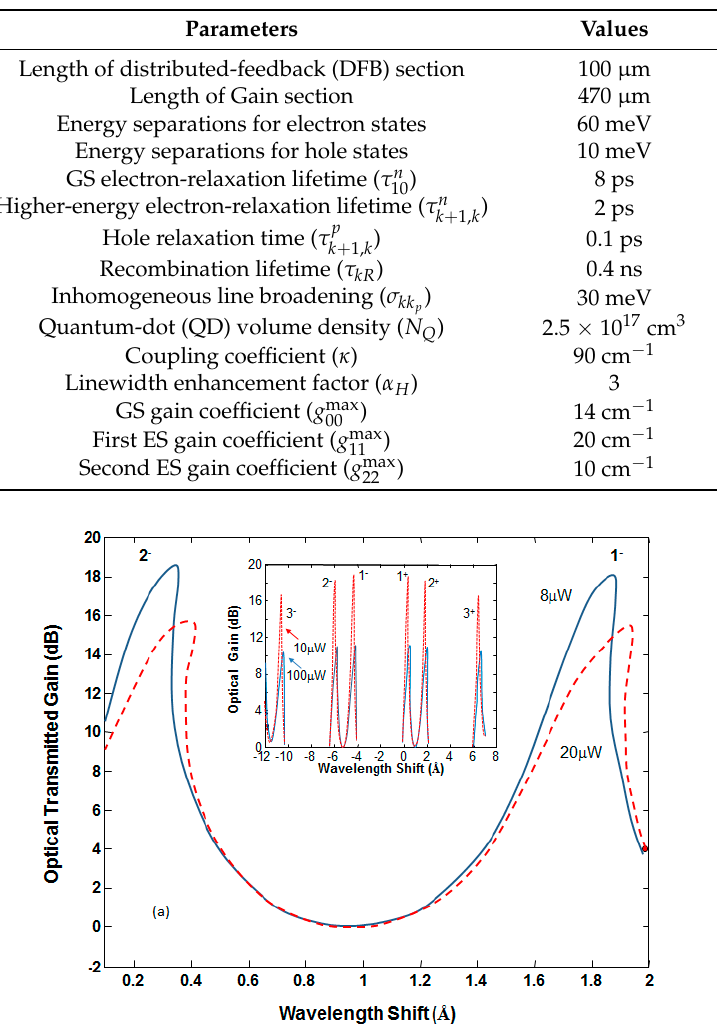
Table 1. Parameters used for the investigated device.